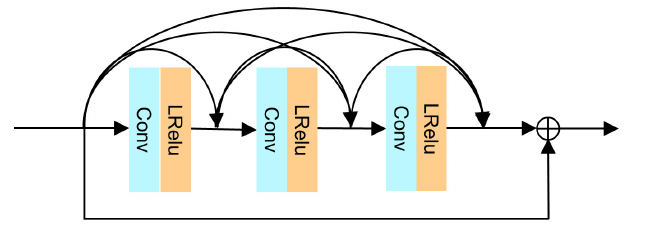
Figure 3. The architecture of residual dense block, where LRelu is leakyRelu.